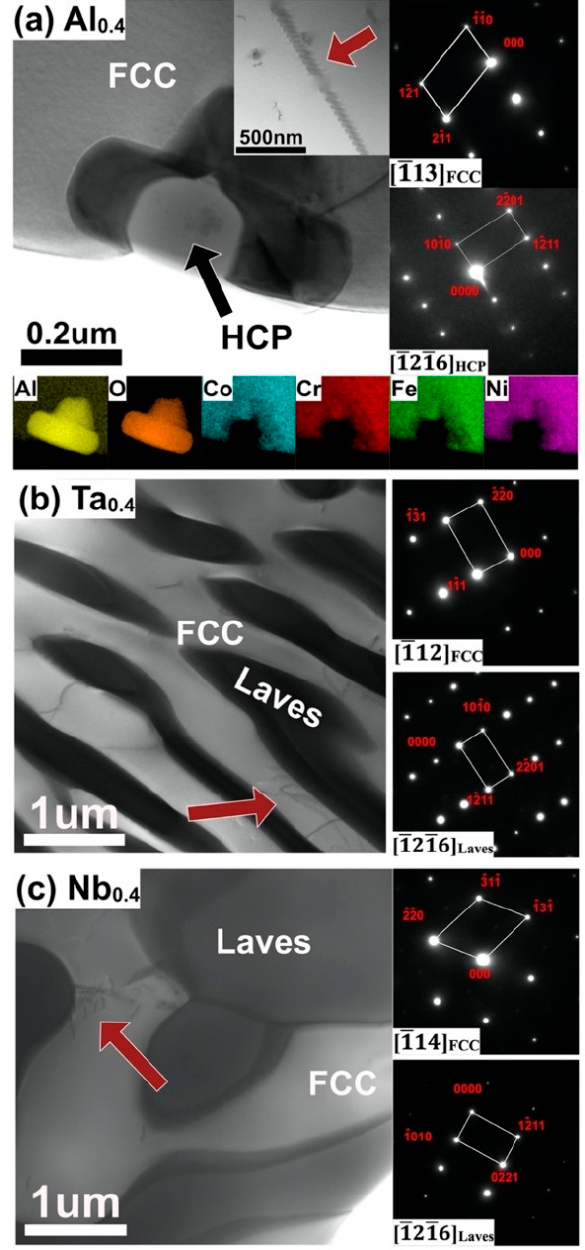
Figure 1. TEM micrographs, with the illustration of the selected area diffraction pattern (SADP) in ( a ) CoCrFeNiAl 0.4 , ( b ) CoCrFeNiTa 0.4 , and ( c ) CoCrFeNiNb 0.4 high entropy alloys (HEAs), prepared by powder plasma arc additive manufacturing (PPA-AM).